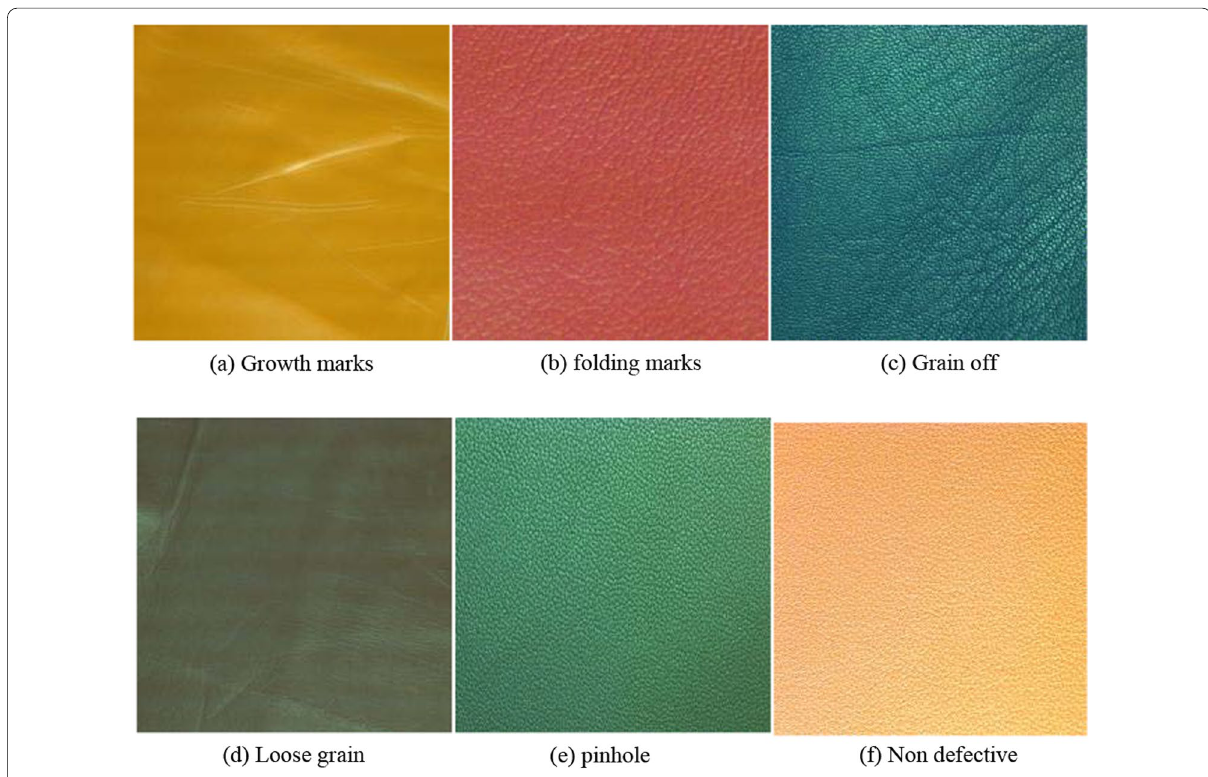
Fig. 2 Samples of leather surfaces with different colours and